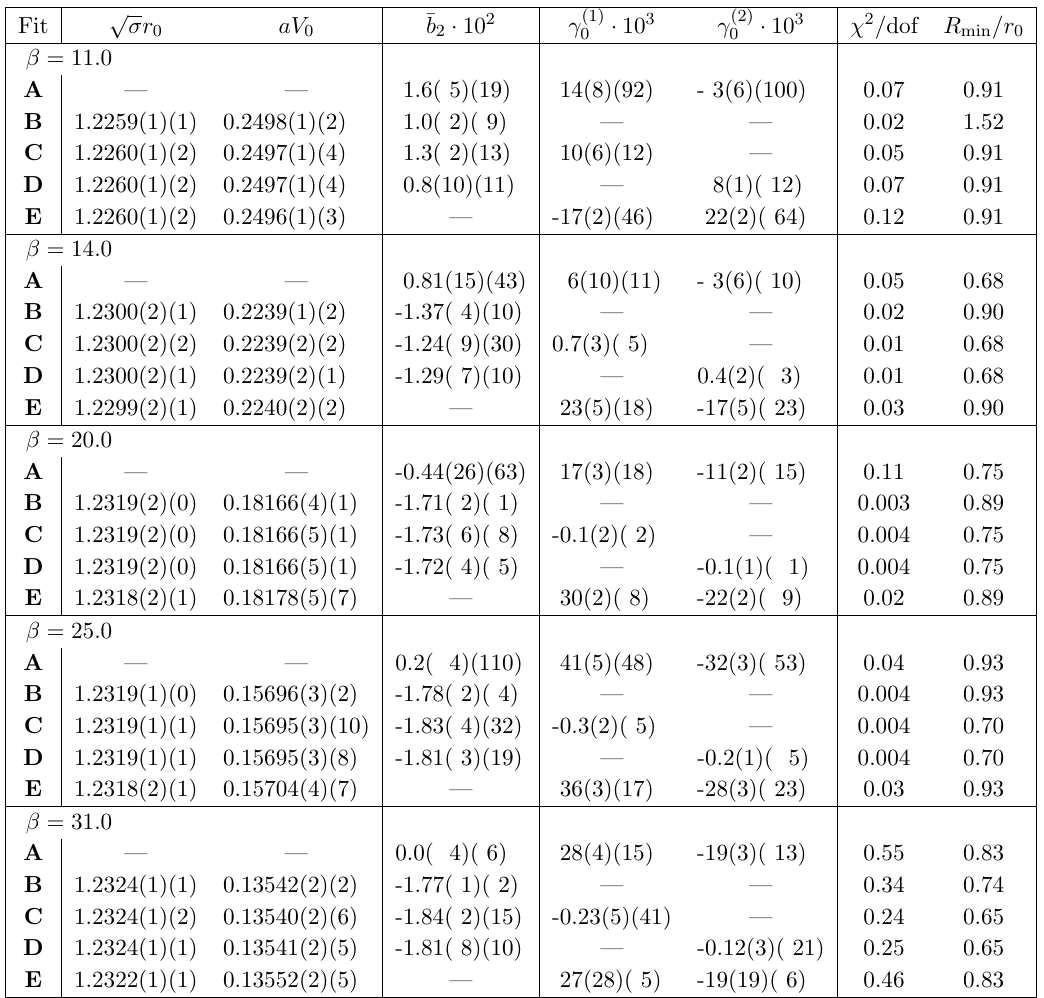
Table 6 . Results of the (cid:12)ts for the extraction of (cid:22) b 2 for SU(3) gauge